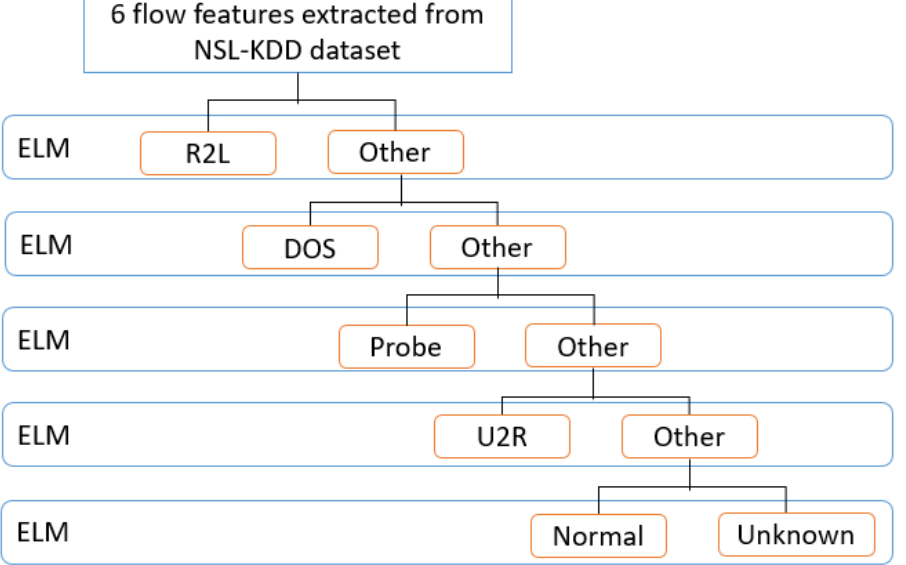
Figure 7. The proposed system architecture.